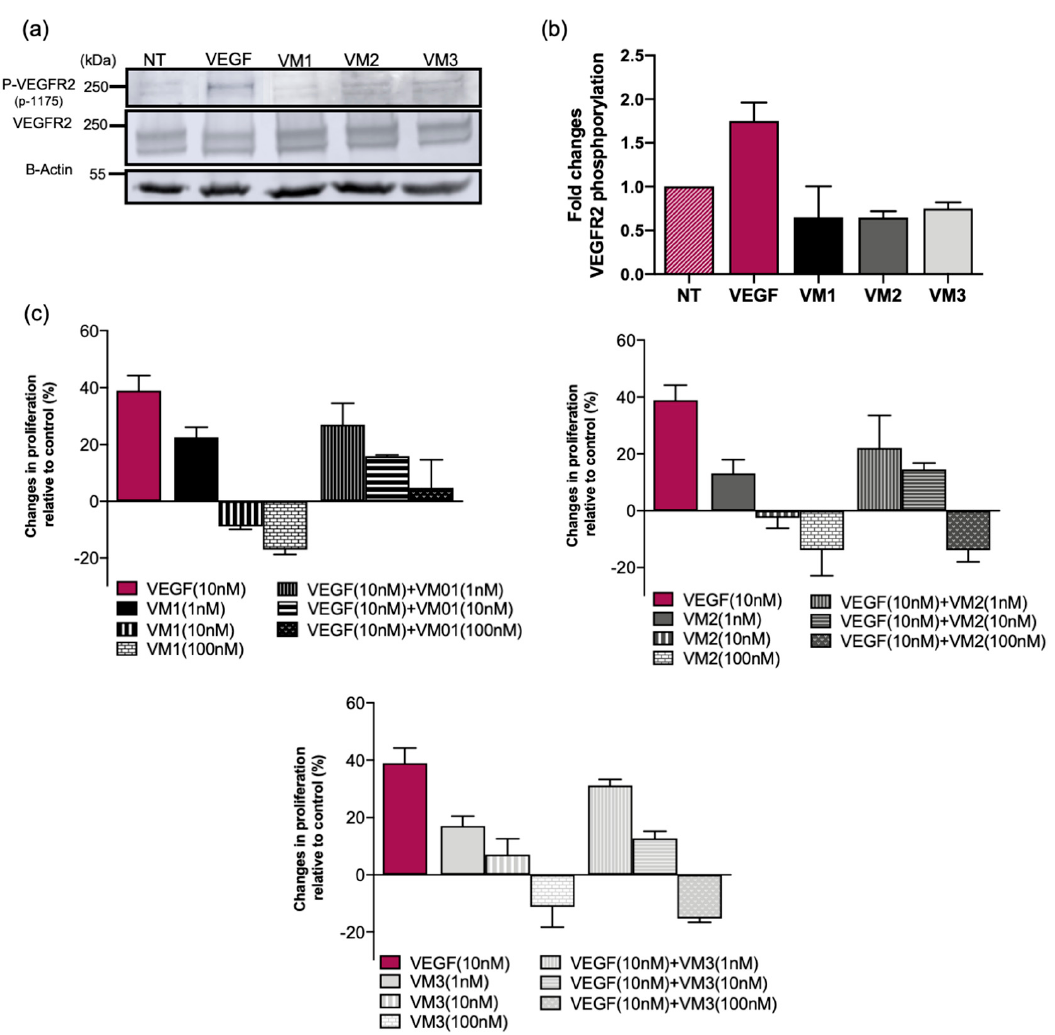
Figure 3. Anti-VEGFR2 NBs blocked VEGF-induced proliferation and did not act as receptor agonists. ( a ) VEGF-A (50 nM) or NBs (1 µ M) were added to the serum-starved MS1 cells and incubated for 15 min. VEGFR2 phosphorylation was measured in the total cell lysates by Western blotting: (top) phosphorylated tyrosine 1175 of VEGFR2; (middle) staining of total VEGFR2; and (bottom)